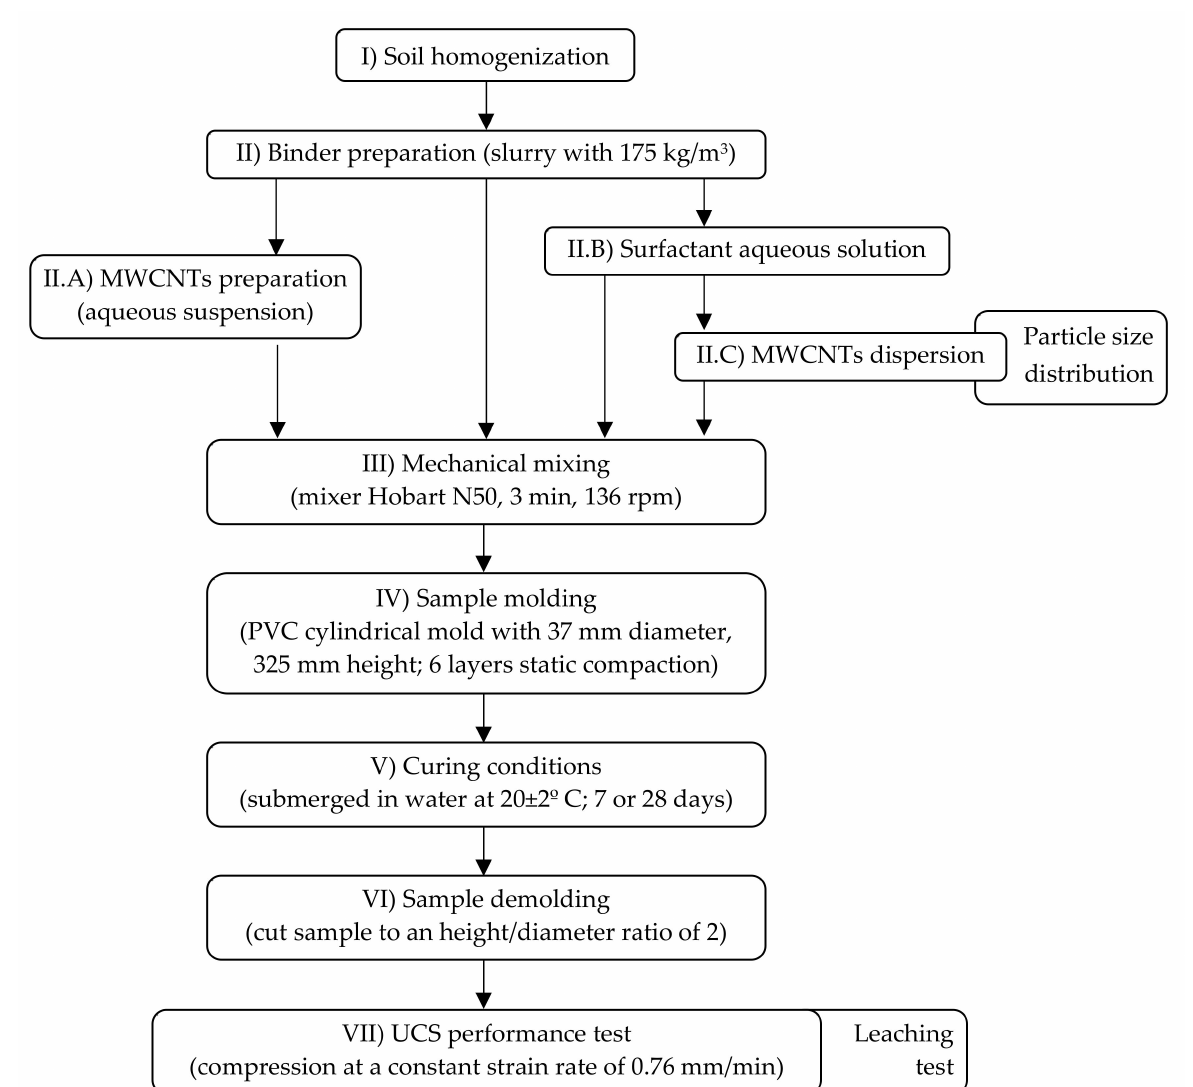
Figure 1. Laboratory procedure for preparation of soil samples chemically stabilized with Portland cement additivated or not with